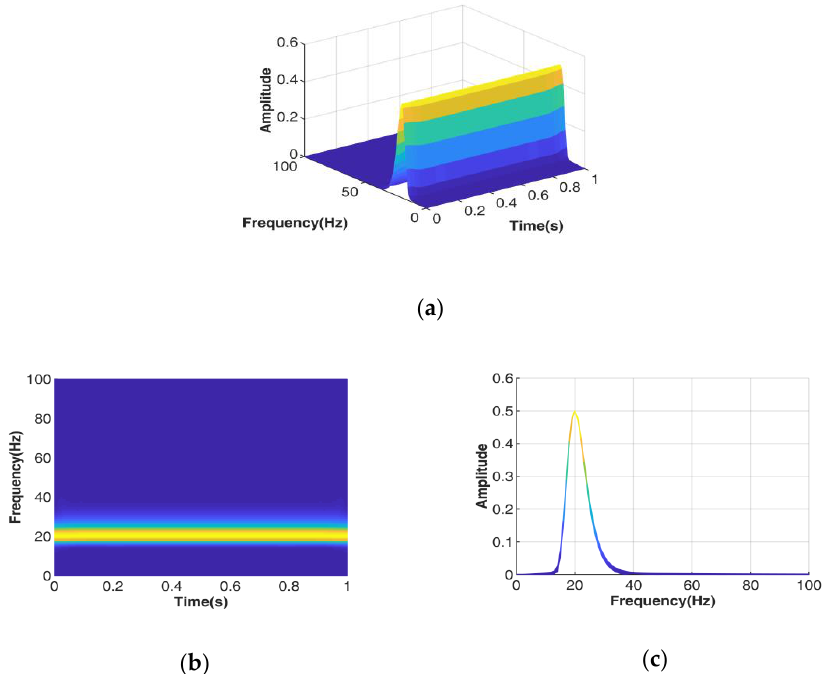
Figure 3. Time-frequency analysis of harmonic signal ST. ( a ) ST three-dimensional representation; ( b ) ST time-frequency representation; ( c ) ST frequency spectrum.